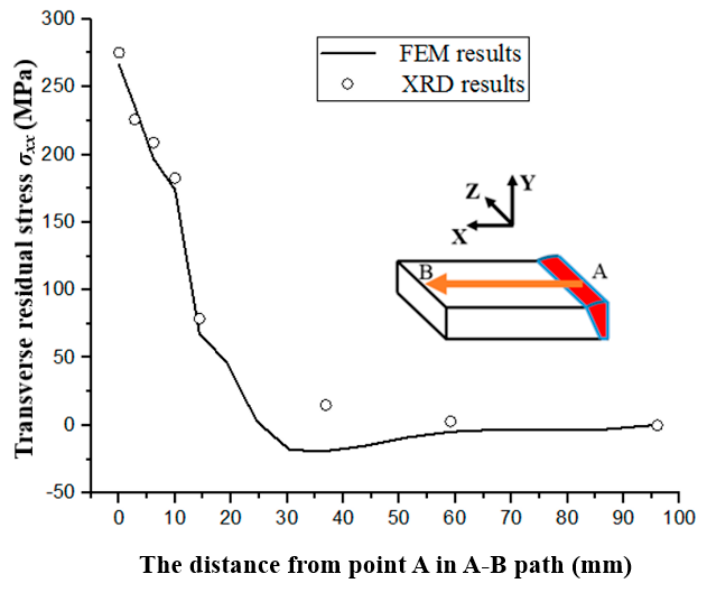
Figure 10. Transverse residual stress σ xx along A–B path.